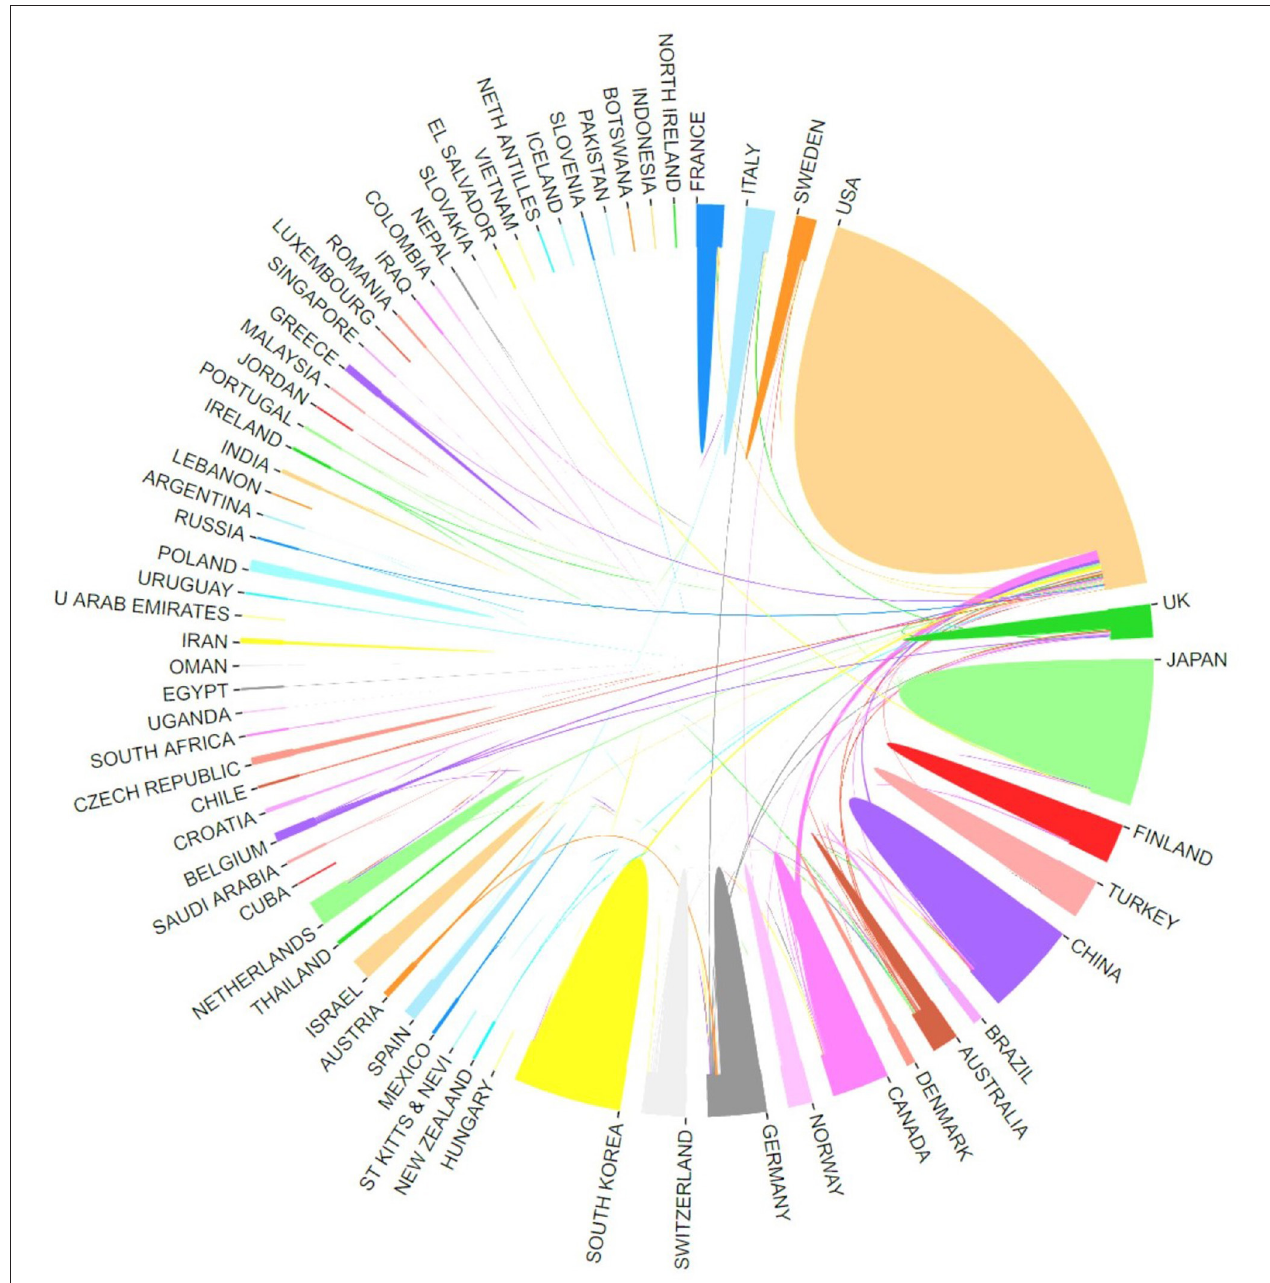
FIGURE 4 | Most active countries or regions. The cooperation of countries/regions involved in spinal stenosis